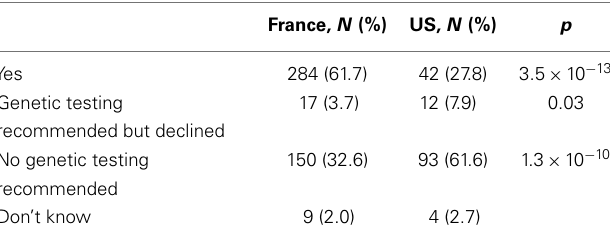
Table 3 | Reported rates of genetic testing performed in affected